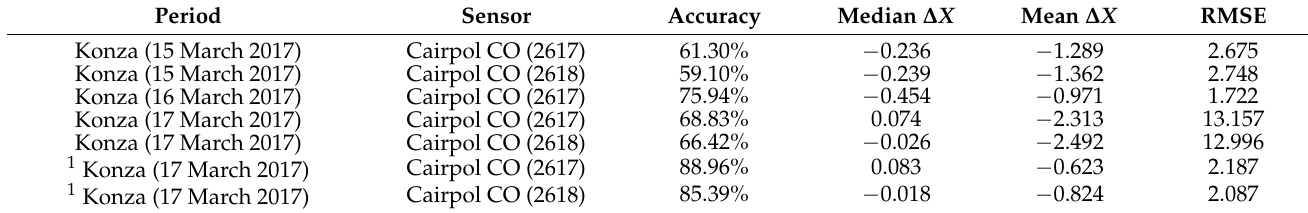
Table A2. Sensor versus reference difference statistics for